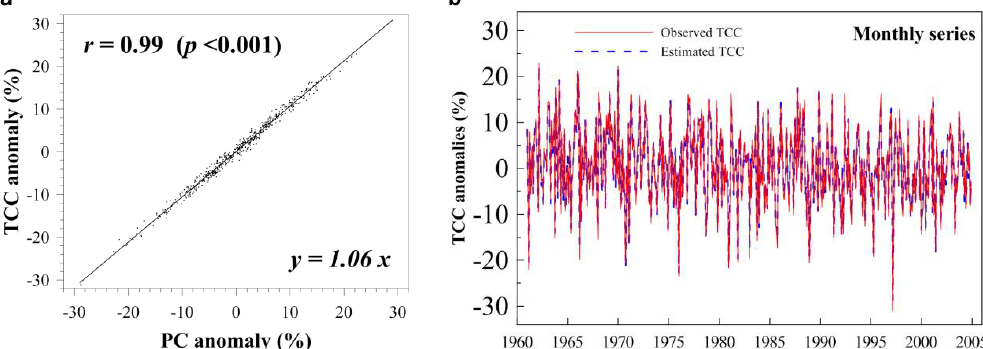
Fig. 2. (a) Scatterplot of the mean monthly anomalies for the observed TCC against the estimated TCC (i.e. parameter of cloudiness, PC) in Spain for the 1961–2004 period. The best fit line is indicated in the plot, together with the linear regression equation and correlation coefficient. (b) Time evolution of the mean monthly anomaly series in Spain of observed and estimated TCC during the 1961–2004 period. The anomalies are expressed as differences from the 1971–2000